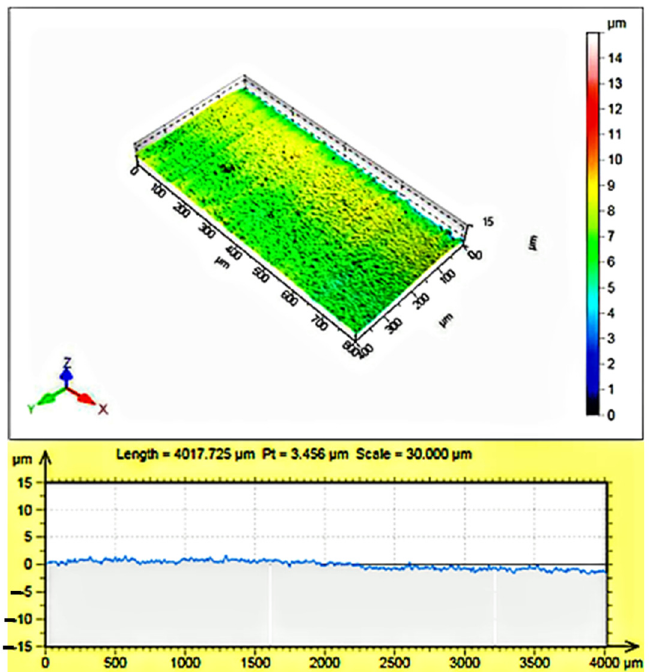
Figure 19. Coherence correlation interferometry measurement for the laser processed PCD workpiece with tilted stage angle of 5.2° (Ra = 0.202 µm).